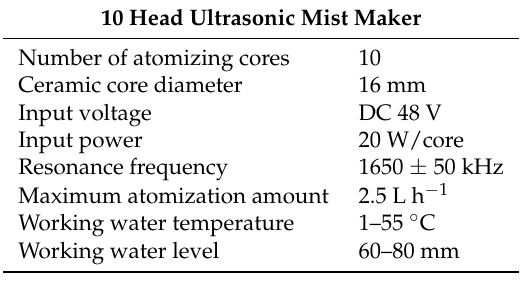
Table 1. Technical specifications and operating conditions of the mist maker unit.